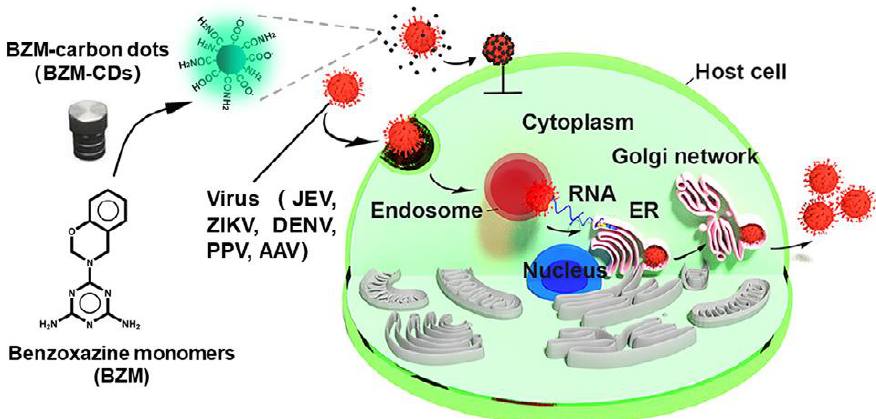
Figure 52. Benzoxazine-derived CD binding to the surface of virions, thus preventing entry of virions into the host cell; the first step of virus–cell interaction (reproduced from the work in [42] with permission).